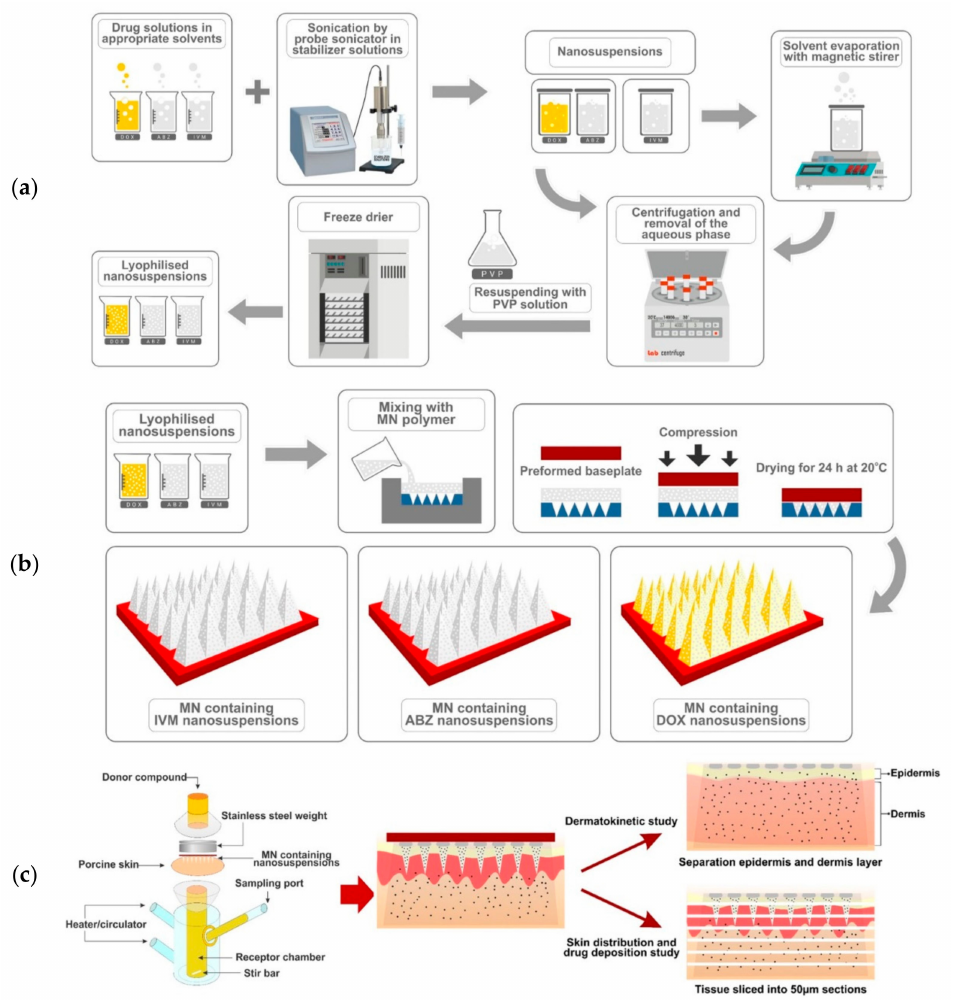
Figure 1. ( a ) Schematic representation of nanosuspension (NS) preparation; ( b ) microneedle (MN) array preparation; and ( c ) dermatokinetic, skin distribution and deposition